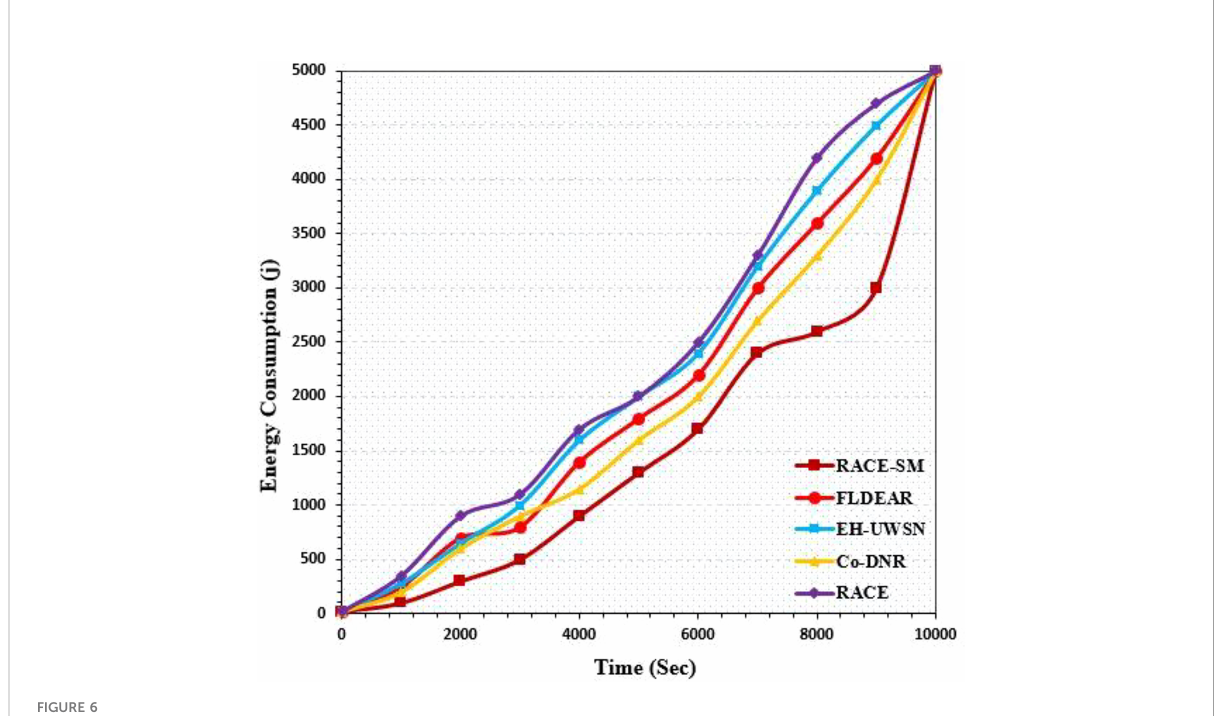
FIGURE 6 Energy